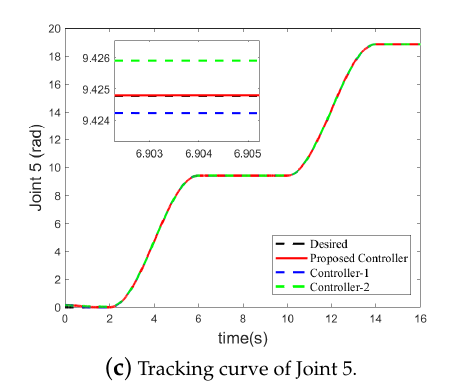
( a ) Tracking curve of Joint 1. ( b ) Tracking curve of Joint 2.